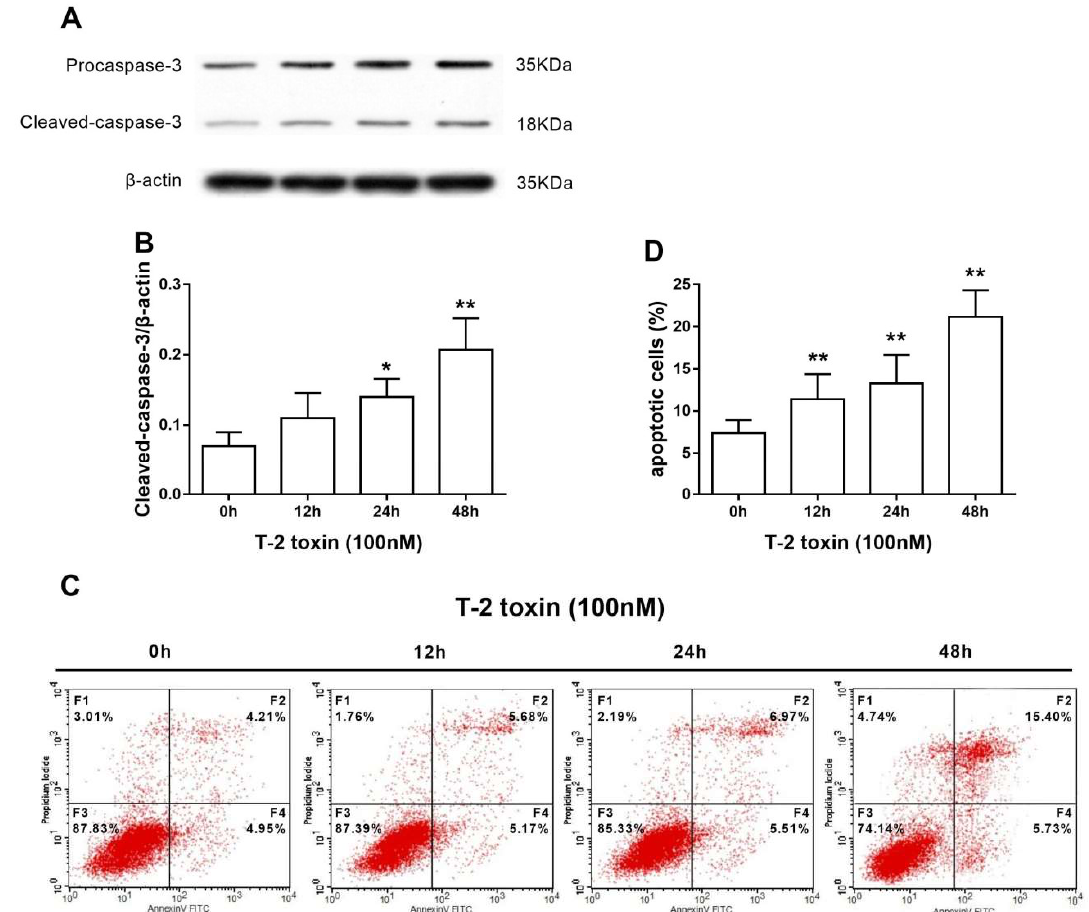
Figure 2. T-2 toxin induces intrinsic apoptosis in TM3 cells. ( A ) Expression of cleaved-caspase-3 was analyzed by Western blotting. ( B ) Level of cleaved-caspase-3 was quantified by densitometry. ( C ) Apoptosis was analyzed by Annexin V/PI assays in TM3 cells. ( D ) Percentage of apoptotic cells treated by T-2 toxin. T-2 toxin induced apoptosis in a time-dependent manner. * indicates p < 0.05 and ** indicates p < 0.01 when compared with the untreated group. Each experiment was performed and repeated at least three times.